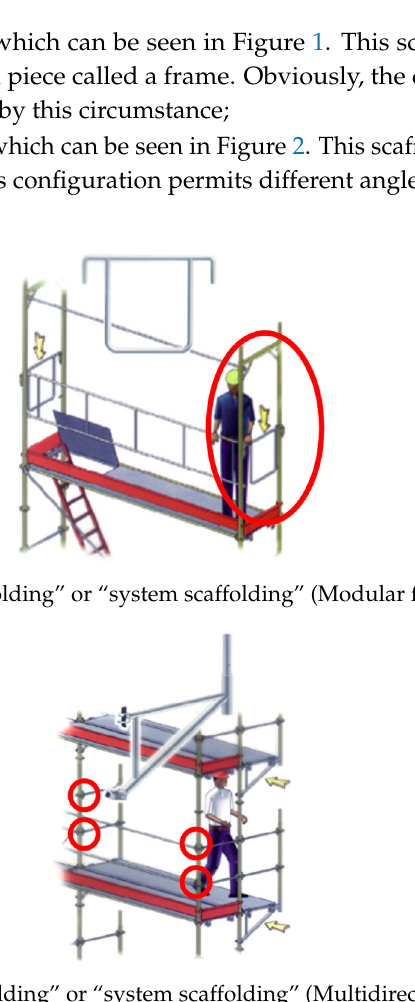
Figure 2. “Standardized scaffolding” or “system scaffolding” (Multidirectional scaffolding) [10].